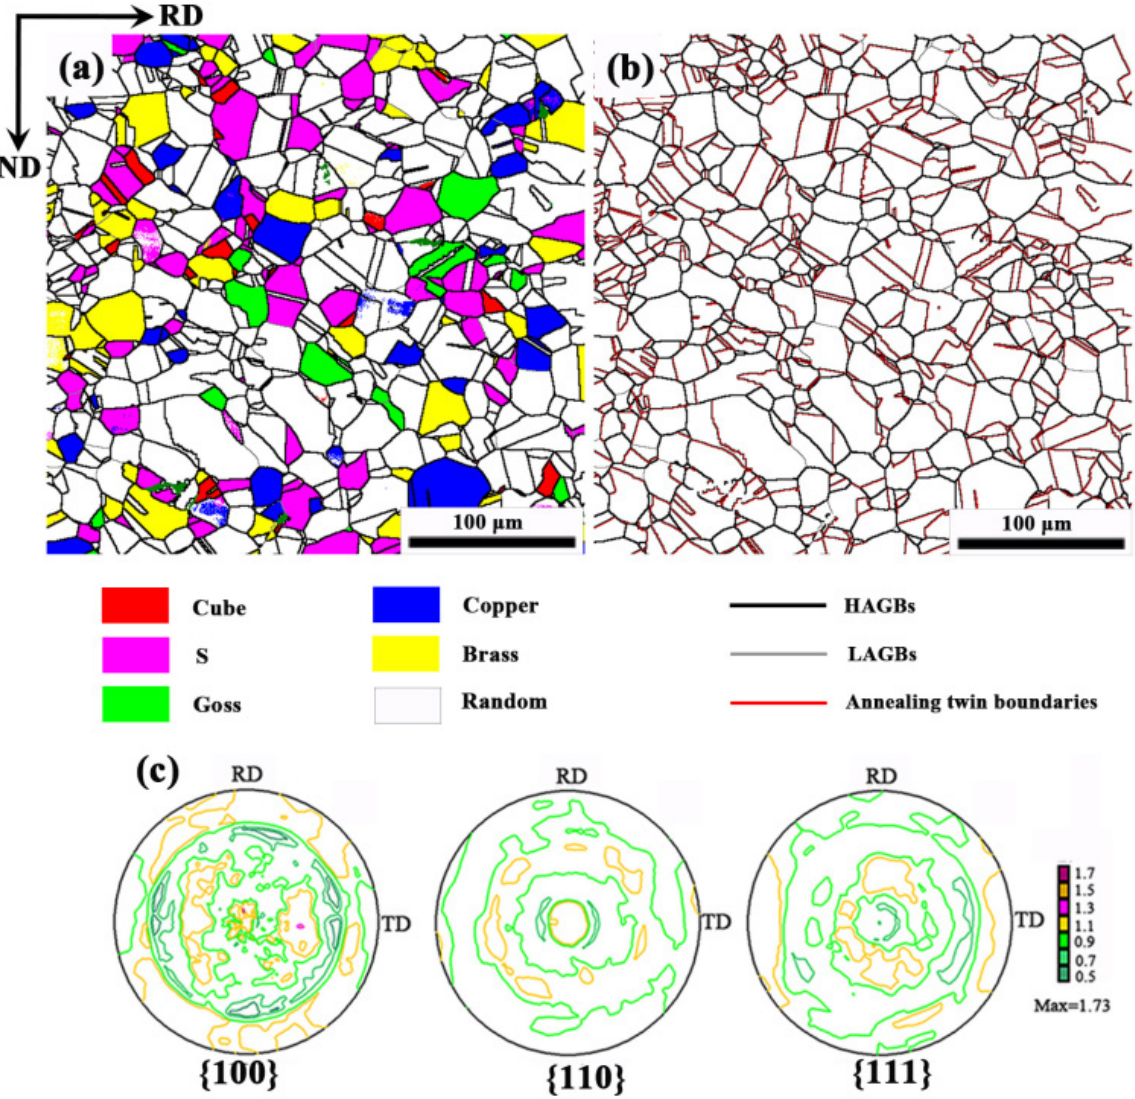
Figure 2: (a) Grain boundary map, (b) orientation image map and (c) pole figures for the as-received